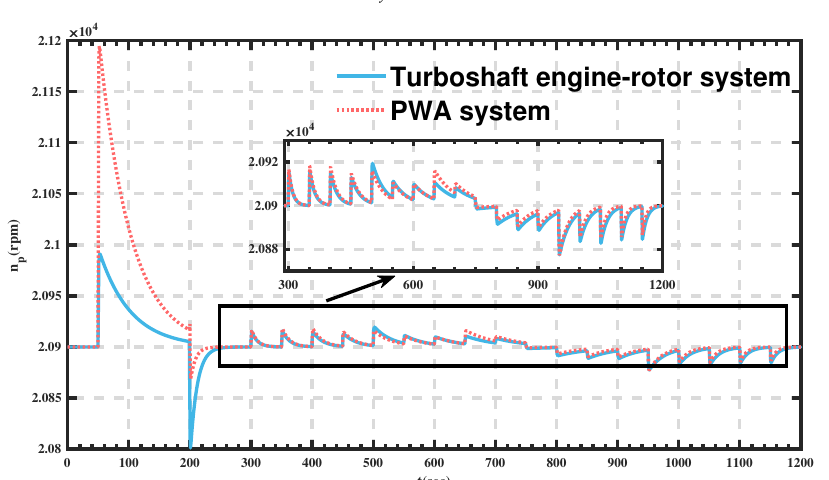
Figure 7. Step input signals of fuel w f and collective pitch xcpc .